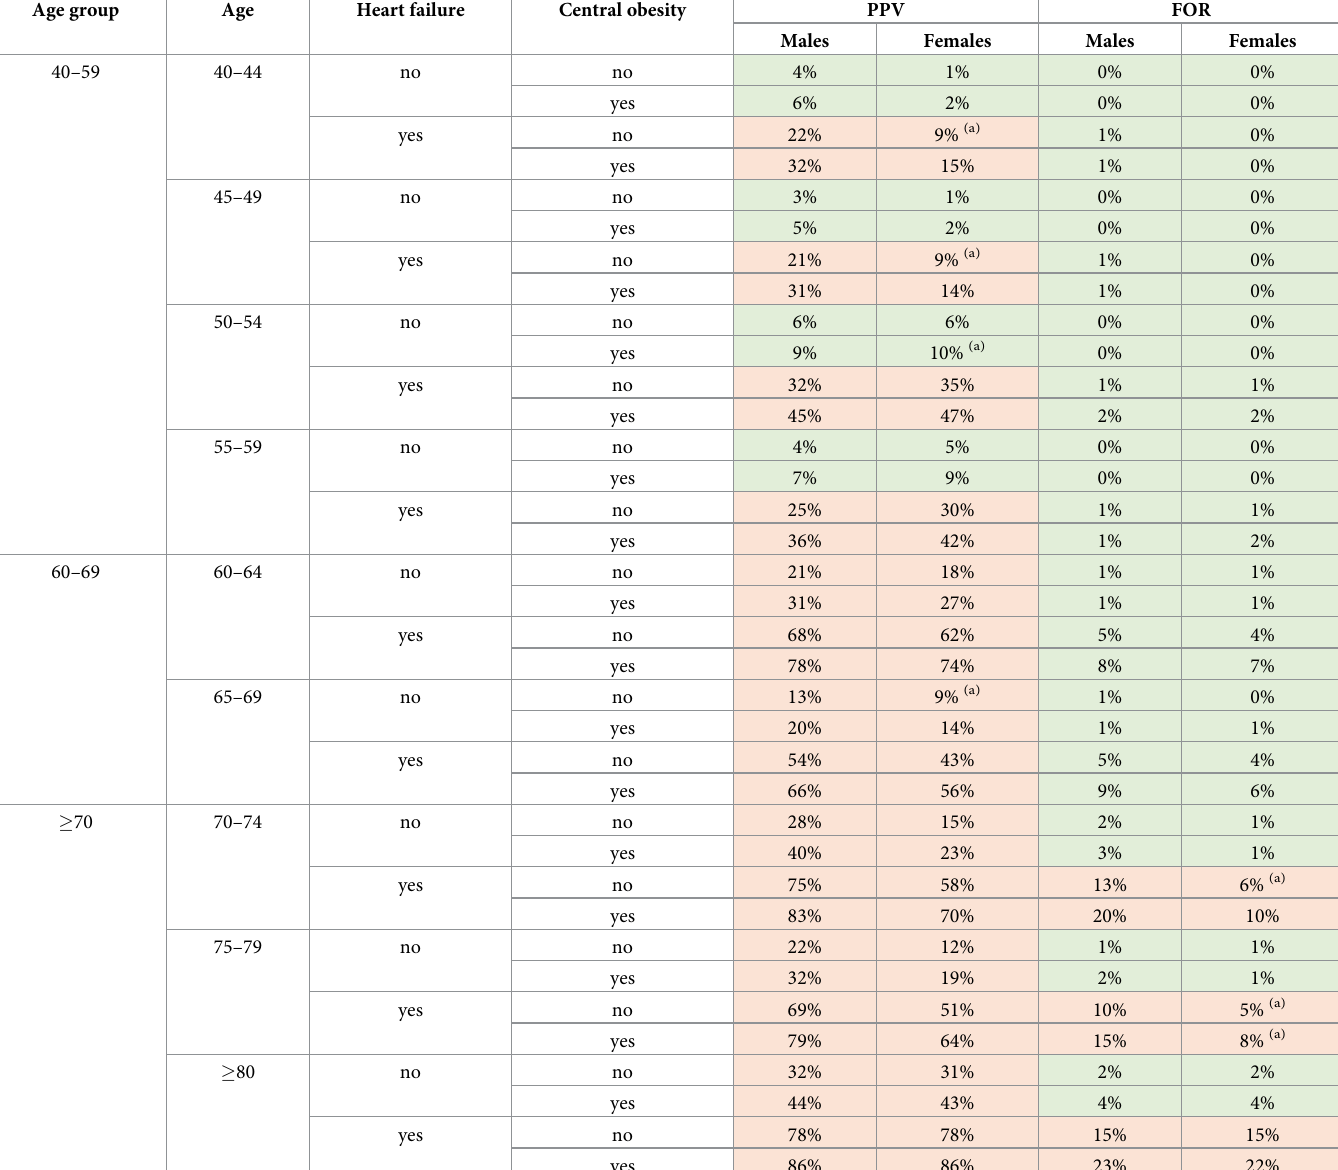
Table 3. Predictive positive values (PPV) and false omission rates (FOR) of pulse palpation to detect atrial fibrillation depending on clinical factors used to create the algorithm to indicate pulse palpation (and if positive ECG) or ECG (without previous pulse palpation) in primary care. Age